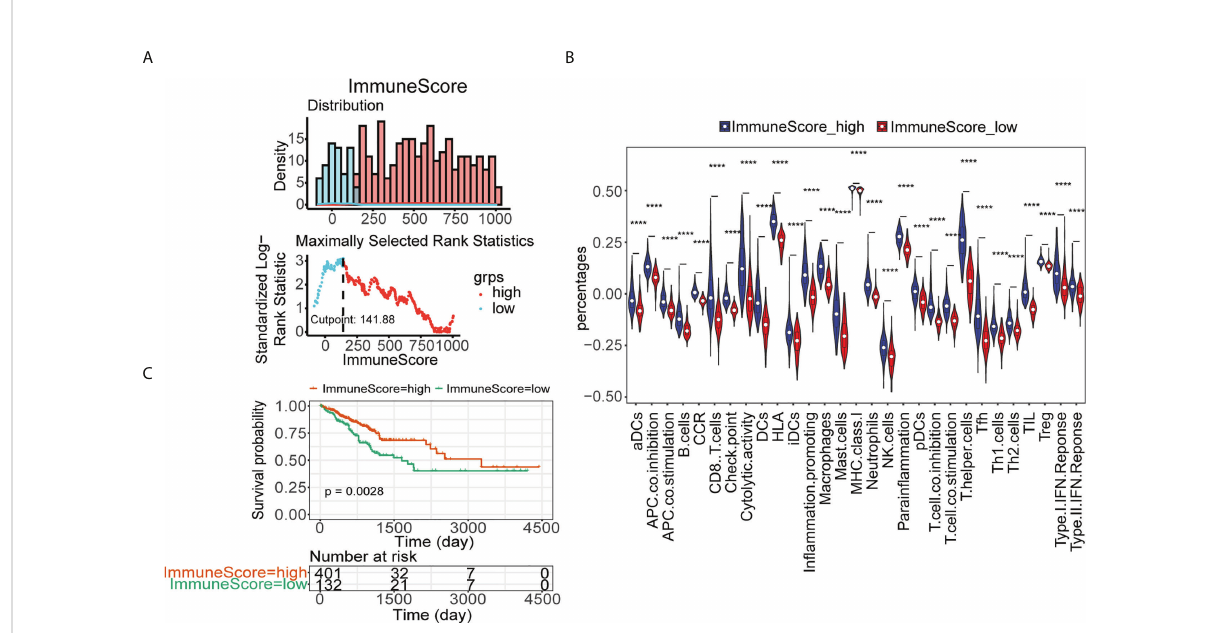
FIGURE 3 Identi fi cation of low- and high-immune groups in TCGA. (A) The optimal threshold of immune score calculated by ESTIMATE. (B) The abundance of 29 immune cells estimated by ssGSEA in immune score high and immune score low groups in TCGA. (C) Kaplan – Meier analysis of TCGA-CRC patients ’ survival in low- and high-immune score groups ****p<